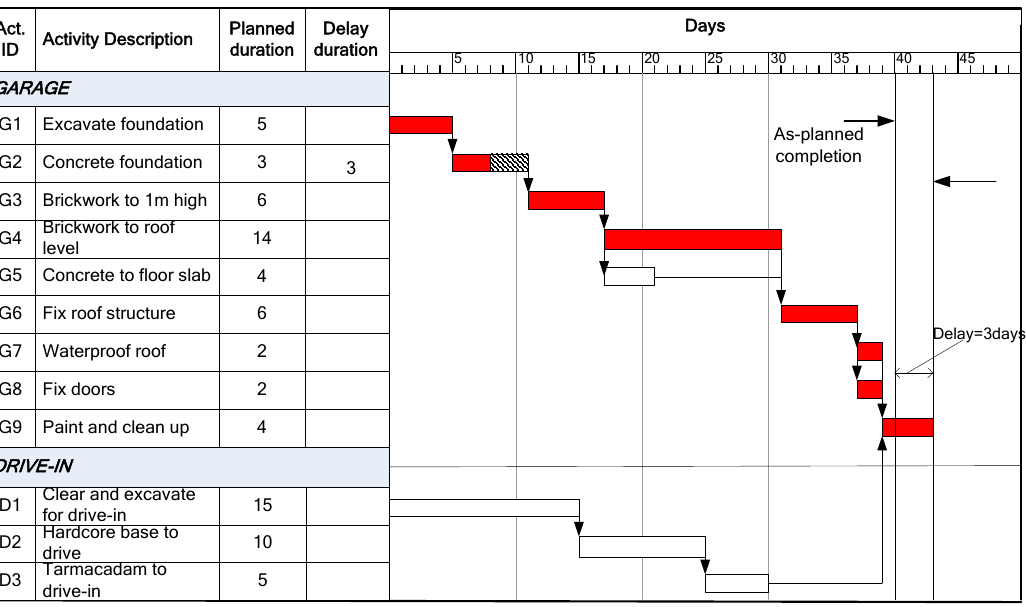
Figure 5. Impact of first delay.